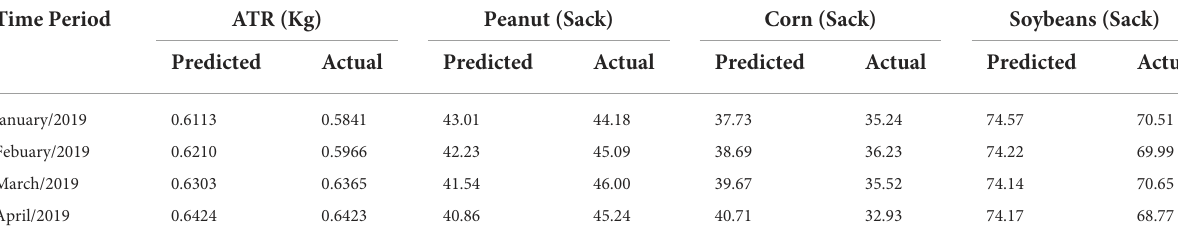
TABLE 4 Predicted and actual monthly values in Reais (R$) for the months January to April 2019 for the commodities studied. Time Period ATR (Kg) Peanut (Sack)